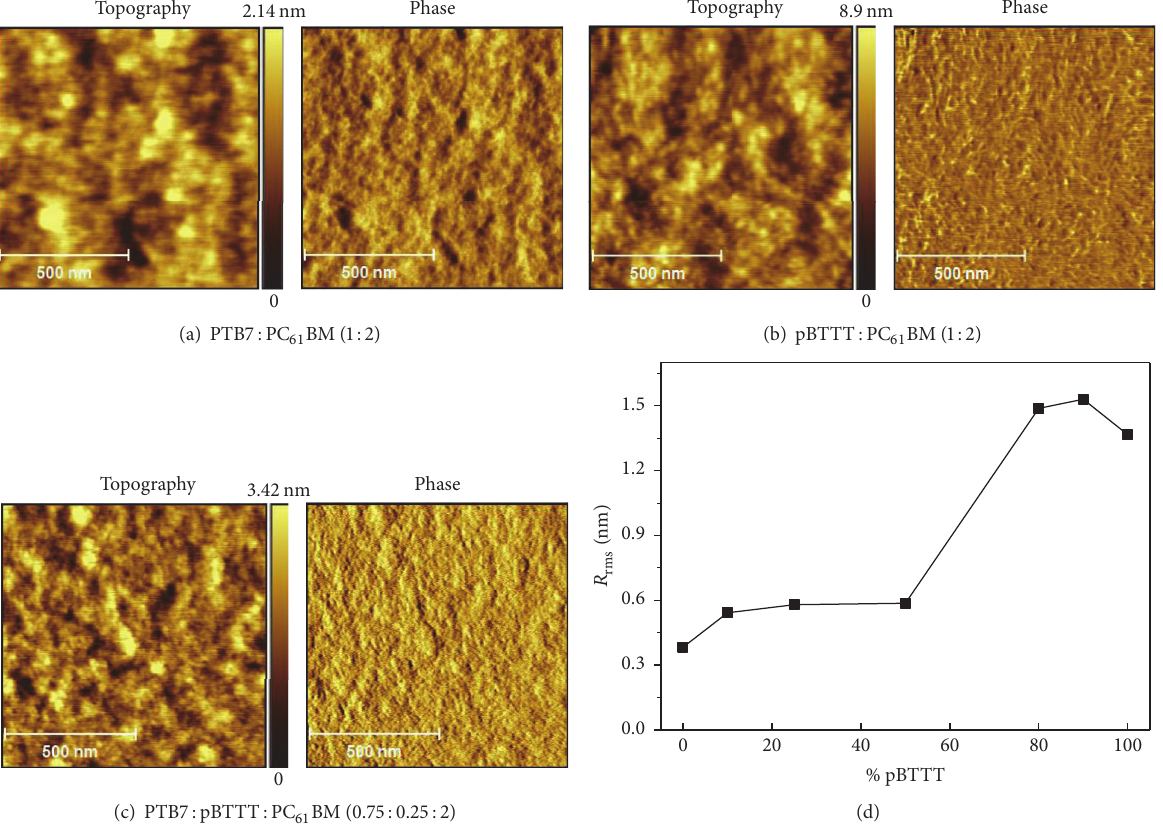
Figure 5: AFM topographic and phase images (1 × 1 𝜇 m 2 ) of (a) PTB7: PC 61 BM (1:2); (b) pBTTT:PC 61 BM (1: 2); (c) ternary blend films of PTB7:pBTTT: PC 61 BM with 25 wt% of pBTTT replacing PTB7. All the films were prepared onto glass/ITO/PEDOT: PSS substrates. (d) 𝑅 rms of the various films as a function of pBTTT content